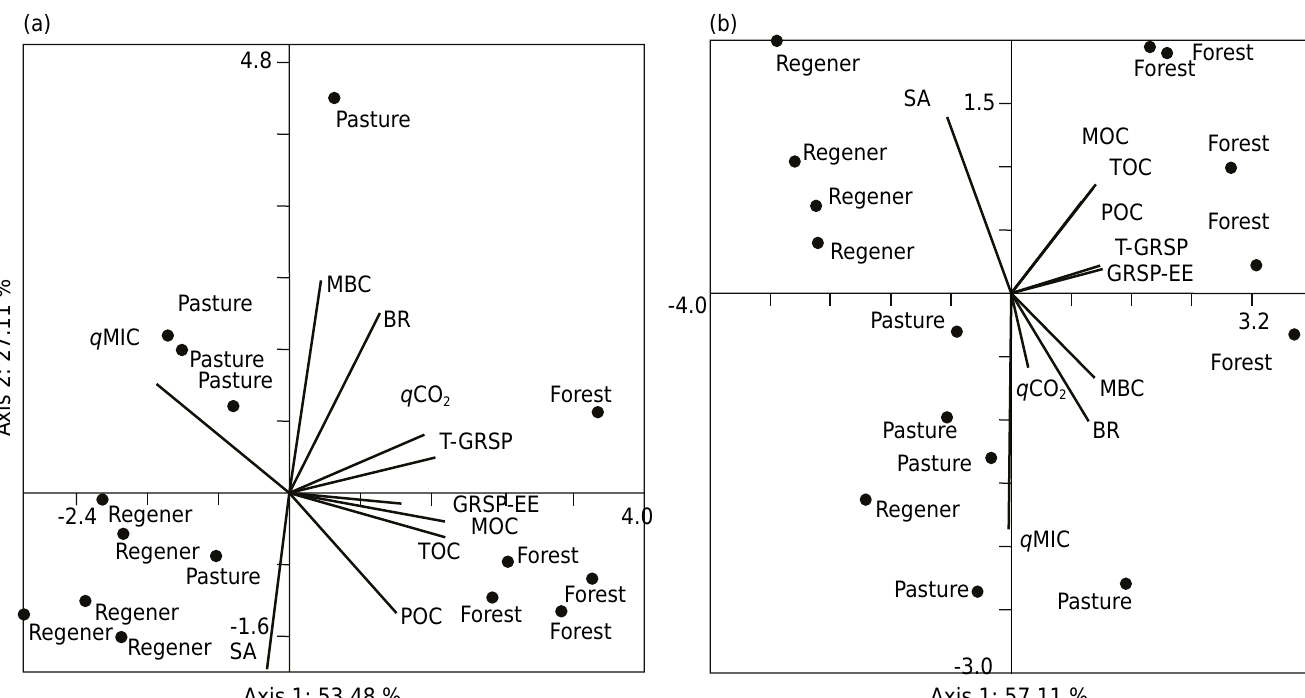
Figure 2. Ordination diagram produced by principal component analysis of topsoil properties (0.00-0.05 m) associated with organic matter and microorganisms in areas of natural regeneration (Regener.), natural pasture, and a fragment of native forest on the Palmital farm in Passa Vinte, MG, Brazil, sampled in the dry (a) and rainy (b) season. T-GRSP: total glomalin-related soil protein; EE-GRSP: easily extractable glomalin-related soil protein; BR: soil basal respiration; MBC: microbial biomass carbon, q CO 2 : metabolic quotient; q MIC: microbial quotient; POC: particulate organic carbon; MOC: mineral associated organic carbon; TOC: total organic carbon; SA: spore